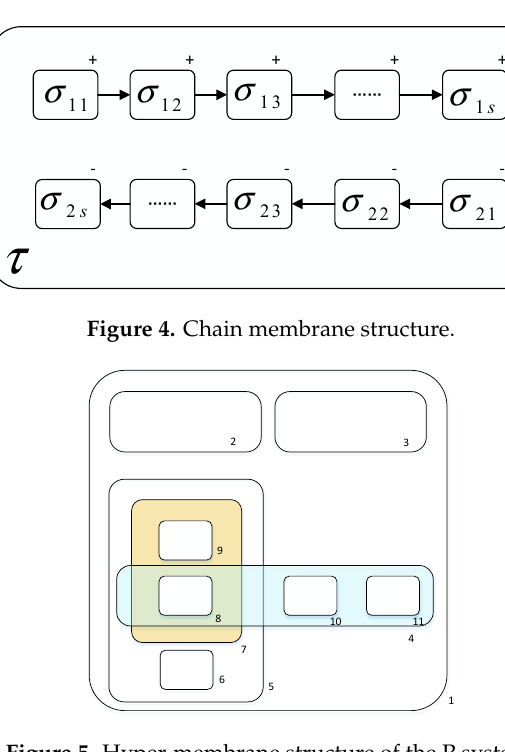
Figure 5. Hyper-membrane structure of the P Figure 5 . Hyper-membrane structure of the P system